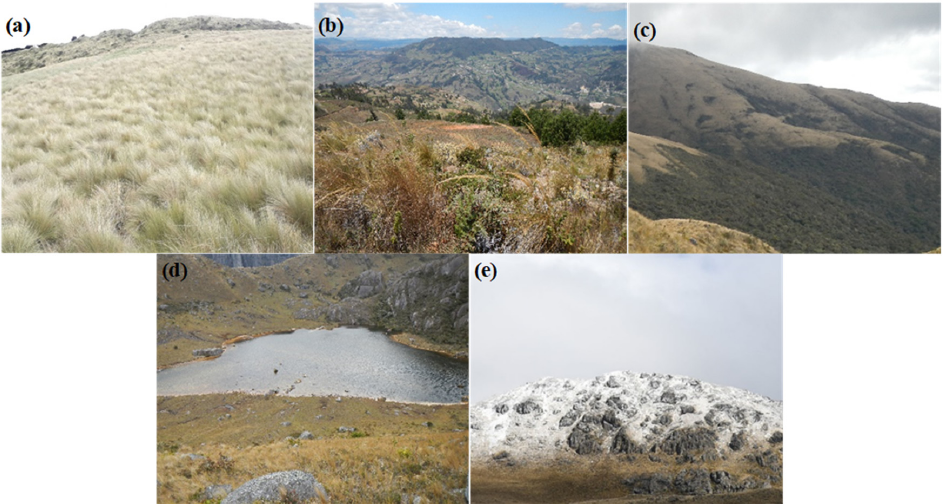
Figure 3. Typical characteristics of the LULC class identified from field testing and recognized in Lansat 8 Imagery. ( a ) Native herbaceous páramo (NHP); ( b ) anthropogenic herbaceous páramo (AHP); ( c ) forest (FRS); ( d ) water (WRT); and ( e ) snow (SNW).